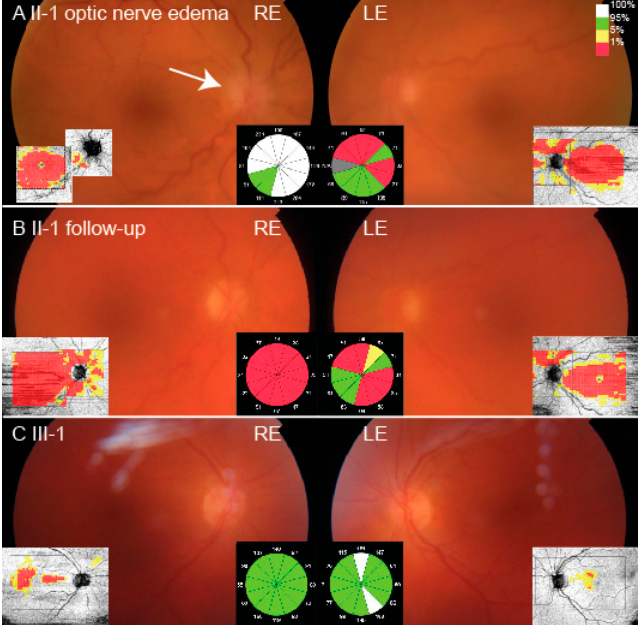
Figure 2. Fundus images of the patient II-1 ( A , B ) and III-1 ( C ). Note the optic nerve edema (white arrow) and vascular tortuosity on presentation in patient II-1 ( A ) which resolved on follow-up 7 weeks later ( B ). The circles placed in the middle represent the thickness of the peripapillary retinal nerve fiber layer where the average thickness of each sector is noted with number in micrometers. The ganglion cell layer thickness in the macula is shown on the side of each fundus image. The different colors represent the comparison of measured thickness with the normative data (with the red color representing thickness observed in less than 1% of the population (see color coded legend placed at the top right corner of the figure)). N/A = not available.